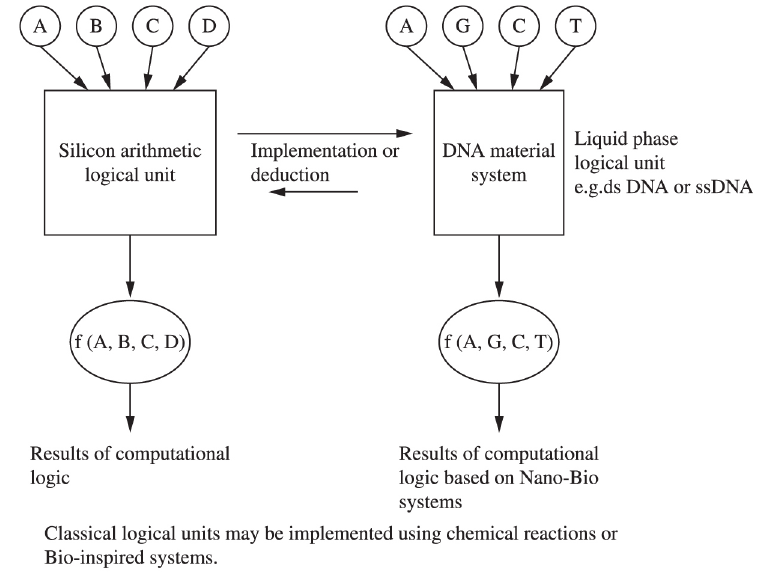
Figure 3. Deduction of bio-inspired systems from classical computing